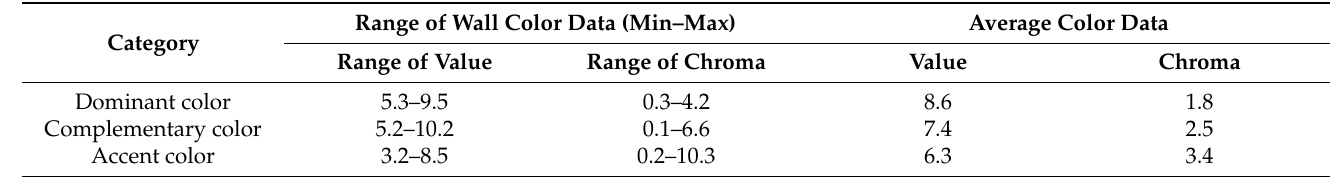
Table 2. Data analysis of environmental colors in public health facilities.